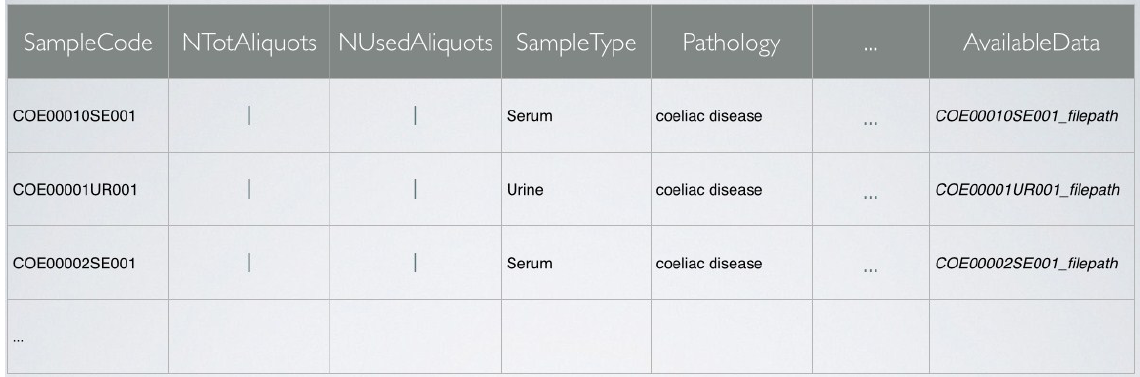
Figure 2. Scheme of the data table for a collection of samples from coeliac patients. The SampleCode field uniquely identifies each sample of the collection.